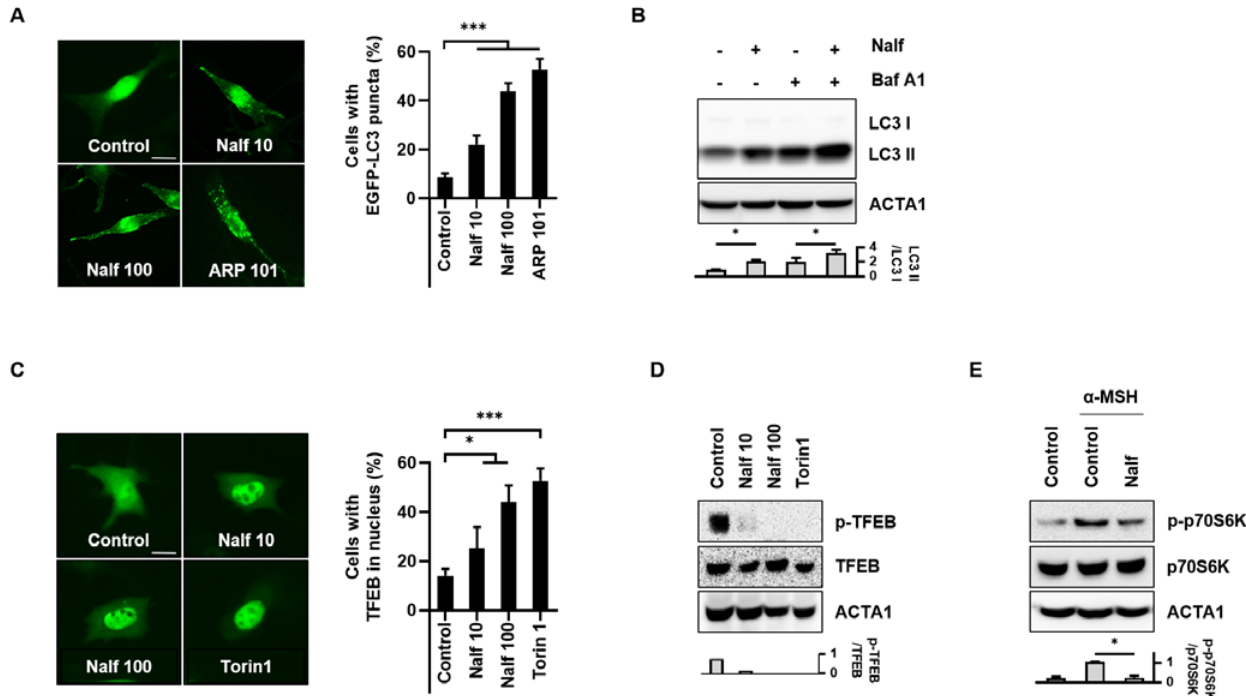
Figure 1. Nalfurafine hydrochloride induces autophagy by inducing translocation of TFEB in α -MSH- treated B16F1 cells. ( A ) B16F1/GFP-LC3 cells were incubated with either nalfurafine hydrochloride (Nalf, 10, 100 µ M) or ARP 101 (10 µ M). ( A ) After 24 h treatment, the cells were fixed and imaged with GFP fluorescence. Cells in which autophagy was activated were determined by counting punctate GFP-LC3 dots under a fluorescence microscope. ( B ) B16F1 cells were treated with nalfurafine hydrochloride (Nalf, 100 µ M) in the presence or absence of bafilomycin A1 (Baf A1, 100 nM) for 24 h. The protein expression of LC3 was then assessed by Western blotting. ( C ) B16F1/GFP-TFEB cells were treated with either nalfurafine hydrochloride (Nalf, 10, 100 µ M) or Torin1 (0.25 µ M for 1 h). The cells were fixed for fluorescence imaging, and the nuclear localization of GFP-TFEB was analyzed. ( D ) B16F1 cells were treated with either nalfurafine hydrochloride (Nalf 10, 100 µ M) or Torin1 (0.25 µ M for 1 h). Protein expression was assessed by Western blotting using the indicated antibodies. ( E ) B16F1 cells pre- treated with α -MSH for 48 h were further incubated with nalfurafine hydrochloride (Nalf, 100 μM) for 24 h. Protein expression was assessed by Western blotting using the indicated antibodies. Additionally, the protein levels were measured by densitometry analysis. (n = 3, ns: non-significant, * p < 0.05, *** p < 0.001.) The scale bar indicates 10 μm.